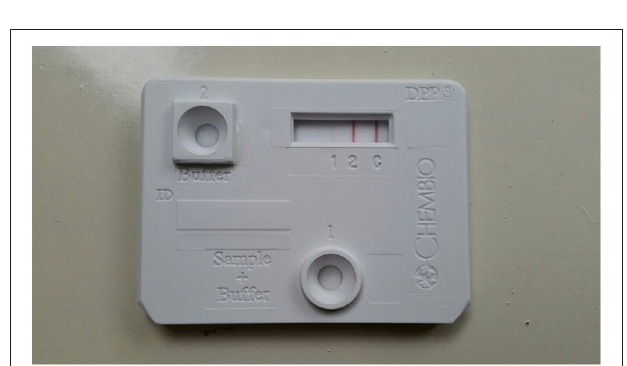
FIGURE 3 | Image of representative histopathological changes in lungs of African elephant with Mtb disease. Granulomas comprised central foci of variably mineralized necrotic debris and clusters of acid-fast positive bacilli encapsulated in variably thick layers of macrophages and epithelioid cells, mixed with small numbers of multinucleate giant cells, lymphocytes, and plasma cells.